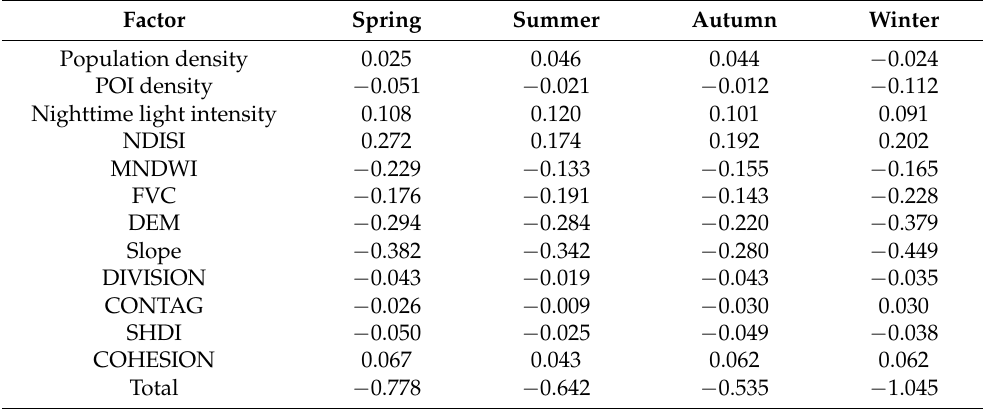
Table 7. Specific effect coefficients of impact